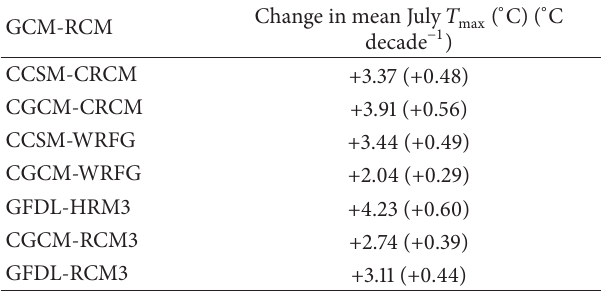
Table 4: Projected change in mean July 𝑇 max in SNP.